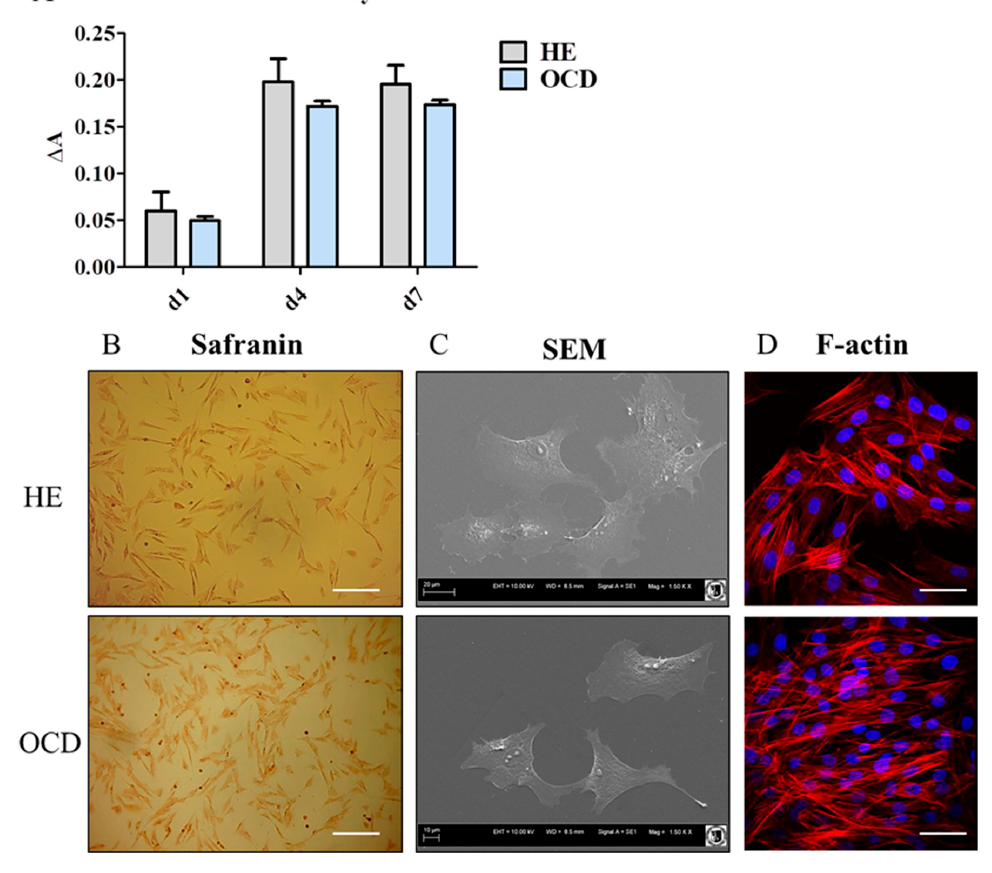
Figure 1. Metabolic activity and morphology of healthy chondrocytes (HE) and osteochondritis dissecans (OCD) chondrocytes. Metabolic activity was assessed using Alamar Blue assay after day 1 (d1), 2 (d2) and 7 (d7) of culture ( A ). Chondrocytes were stained with safranin and observed under phase contrast microscope ( B ). Furthermore, cell were observed in scanning electron microscopy (SEM) ( C ). F-actin was visualized using phallodin and captured with confocal microscope ( D ). Scale bars: brightfield-250 μ m, confocal: 50 μ m. Results expressed as mean ± standard deviation (S.D.).